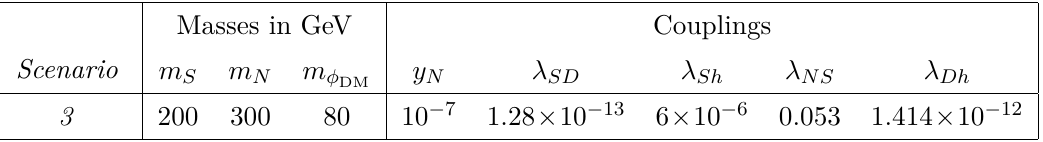
Table 4 . The choices of masses and couplings for Scenario-3